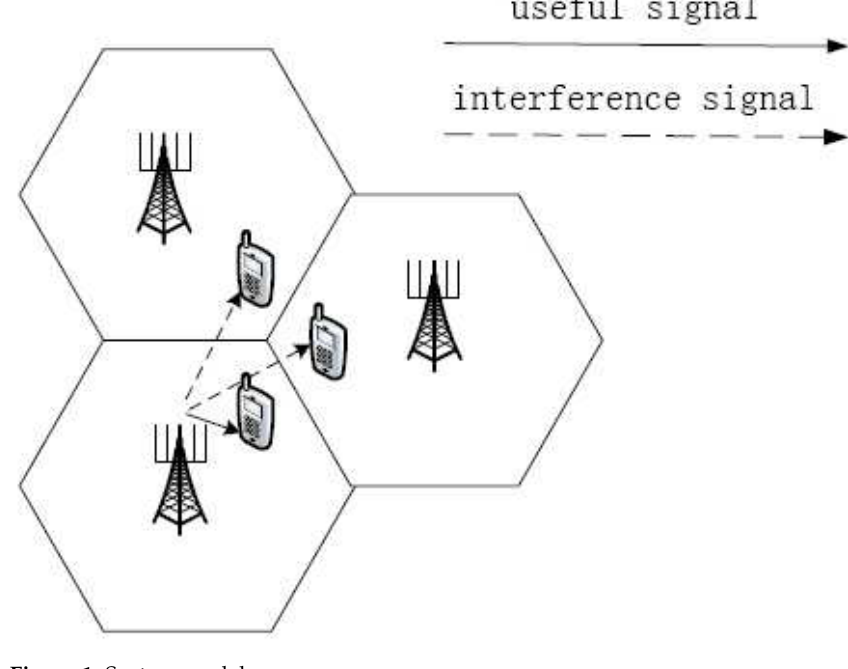
Figure 1. System